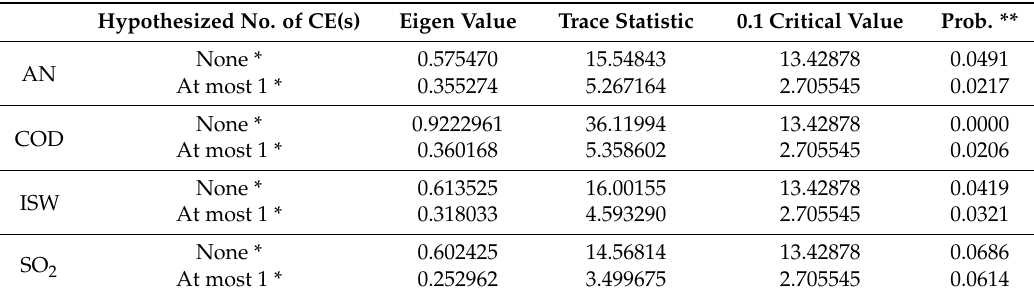
Table 7. Johansen co-integration test for coal mining and washing.